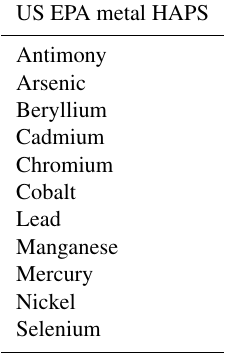
Table 1. List of hazardous metals targeted by the US EPA.